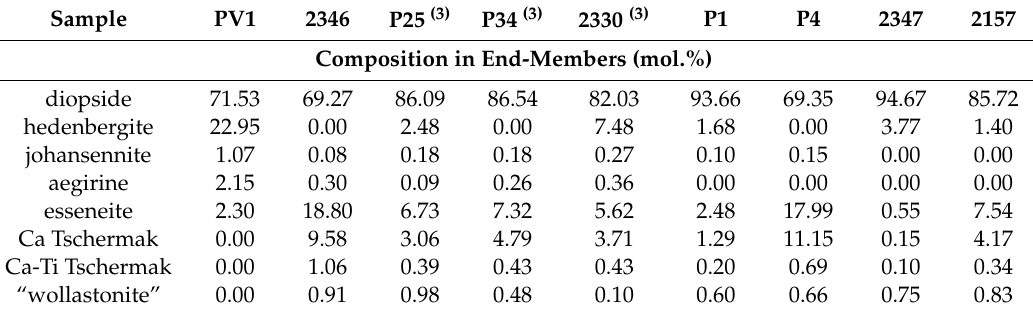
strong tendency to form Si 3 O 9 ternary rings along the c axis, and octahedral layers of CaO 6 polyhedra. The general structure model proposed for parawollastonite [41] appears to be